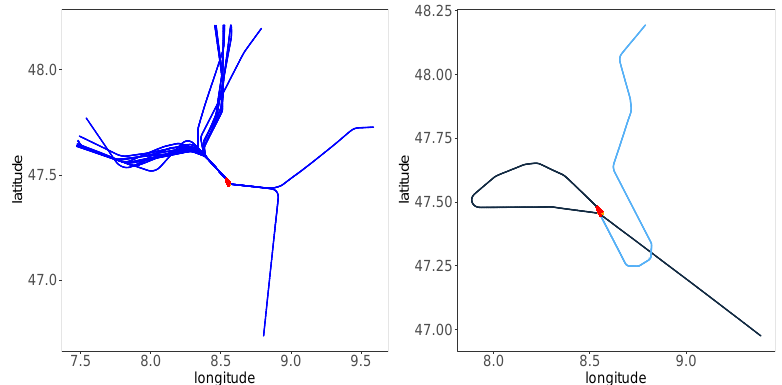
Figure 2. The difference in the track angle between the entering point on the circle and the landing point. (Left) Trajectories with less landing time; (right) trajectories with more landing time.